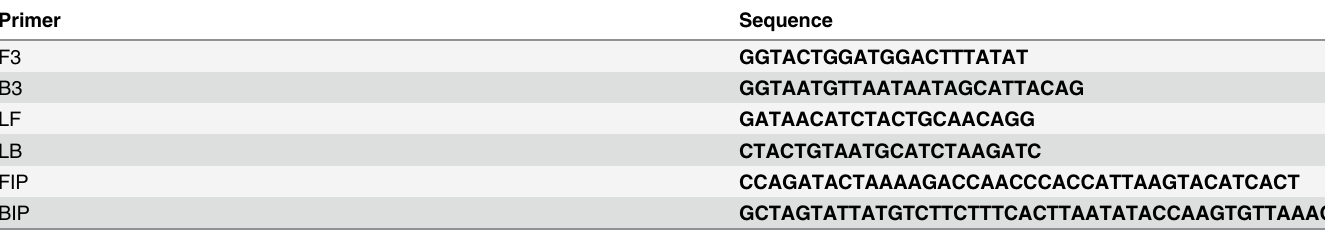
Table 2. P . vivax VIV2 HtLAMP primer sequences (5 ’ ! 3 ’